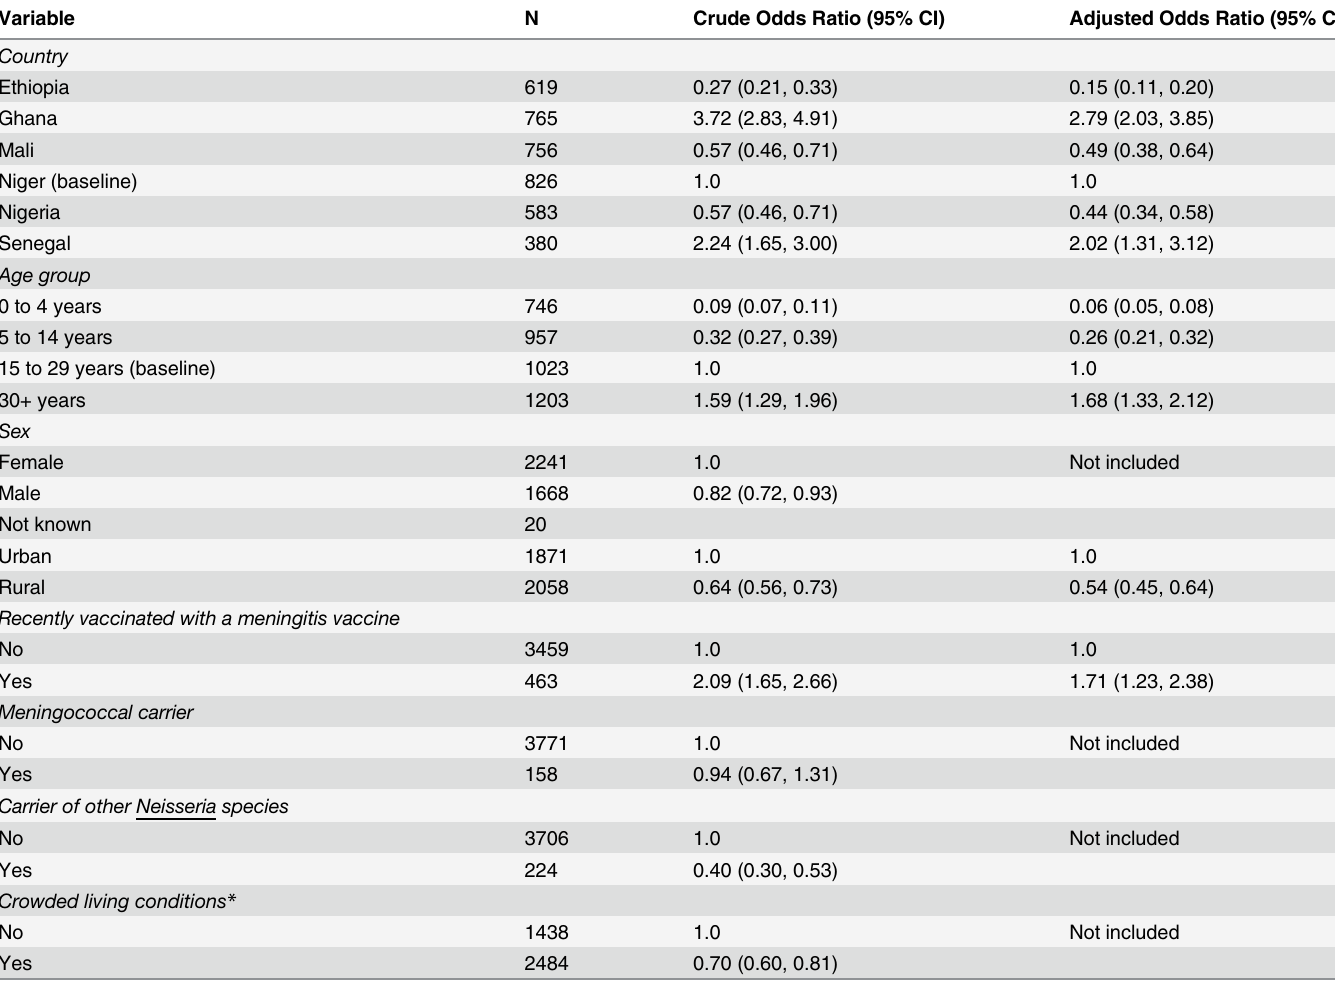
Table 4. Logistic regression analysis of factors associated with a meningococcal serogroup A IgG concentration (cid:1) 2ug/ml, a putative correlate of